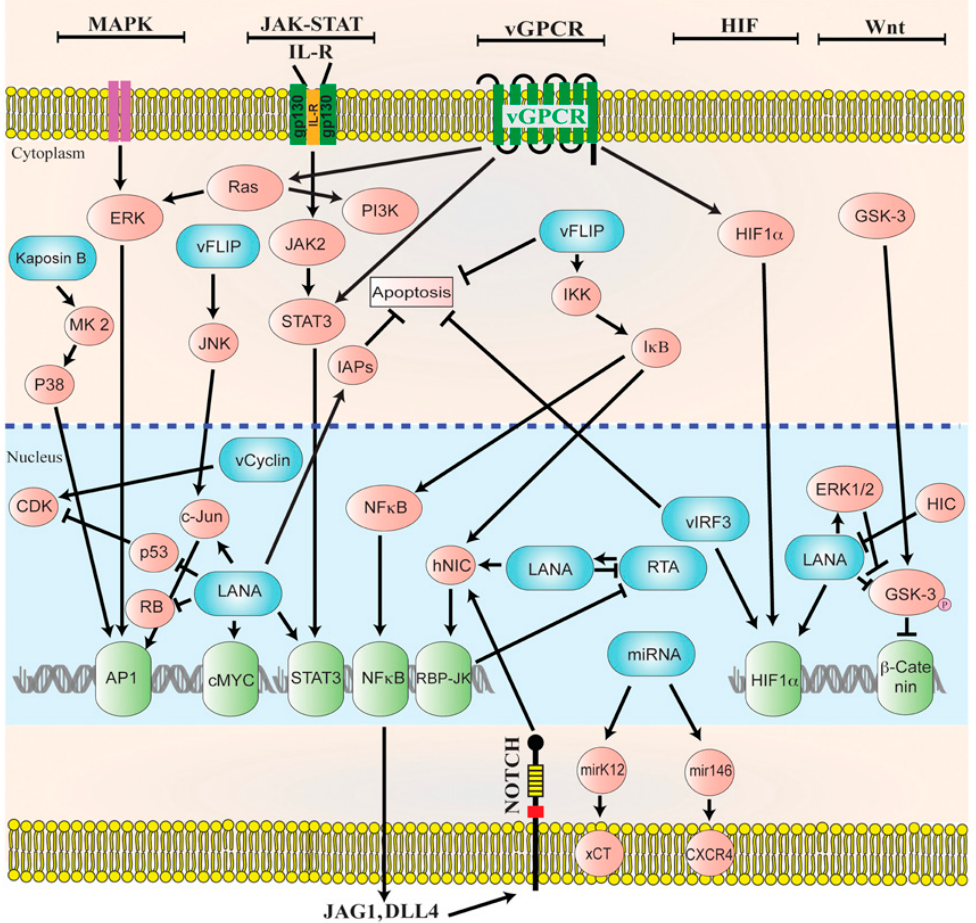
Figure 2. Diagrammatic representation of the cellular signaling pathways in maintaining latency. HHV-8 genome persists as a latent episome within the infected cells by expressing a limited number of viral genes during latency. For a successful establishment of latency, Human Herpesvirus-8 (HHV-8) manipulates and deregulates multiple viral and cellular signaling pathways. HHV-8 latent genes, including latency-associated nuclear antigen-1 (LANA), viral FLICE inhibitory protein (v-FLIP), microRNAs (miRNA), and viral Cyclin (v-Cyclin) activate and maintain various cytokine-mediated cell proliferation and tumorigenesis pathways, such as mitogen-activated protein kinase (MAPK), Janus kinase/signal transducer and activator of transcription (JAK/STAT), mitogen-activated protein kinase/extracellular-signal regulated kinase (MEK/ERK), phosphoinositide 3-kinase/protein kinase B/mammalian target of rapamycin (PI3K/AKT/mTOR), Notch, Wingless-related integration site (Wnt), cMyc, p53, retinoblastoma (RB), and nuclear factor- κ B (NF- κ B), to maintain latent infection. Reproduced with permission from Purushothaman, P., KSHV Genome Replication and Maintenance; published by Front. Microbial. , 2016.